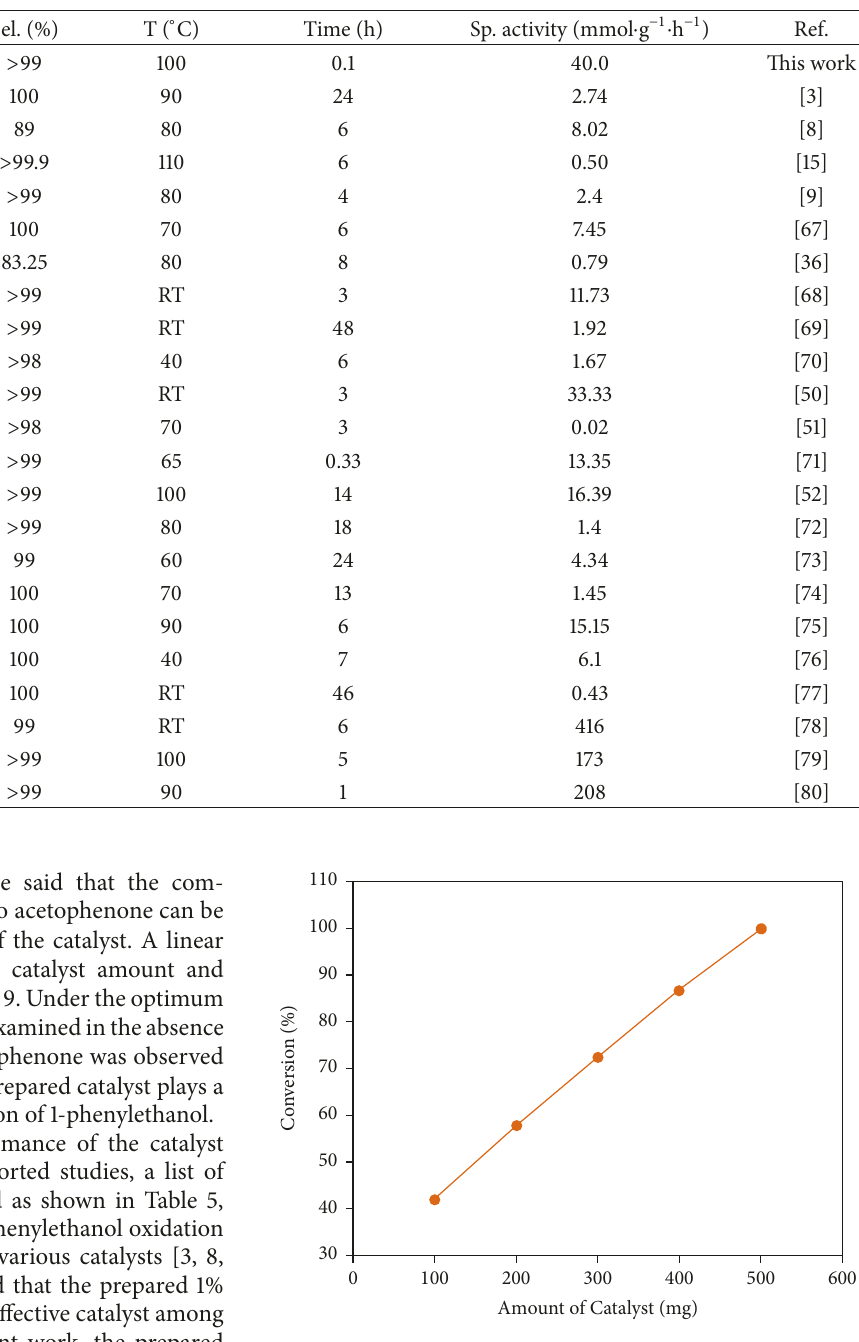
Figure 9: Catalytic activity of 1% ZrO tion of catalyst